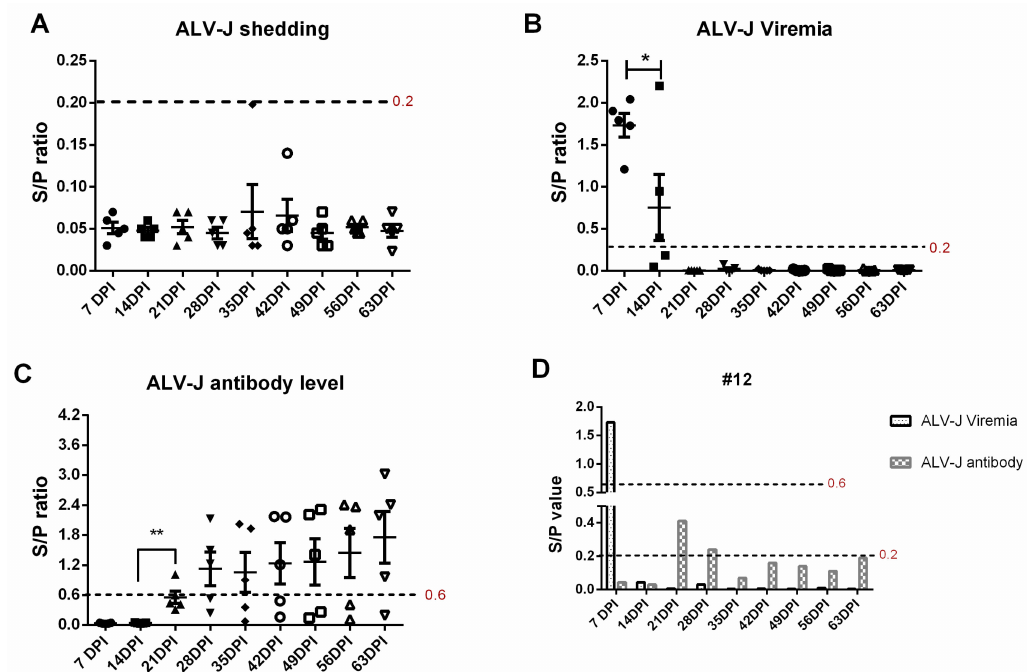
Figure 1. Dynamic detection of the avian leukosis virus subgroup J (ALV-J) shedding, ALV-J viremia, and ALV-J antibody. Five chickens were randomly selected for sampling every seven days post-infection (DPI). ( A ) ALV-J shedding was monitored via detecting the p27 expression levels in cloacal swabs. S / P value below 0.2 (red) indicated negative ALV-J shedding. ( B ) ALV-J viremia was monitored via virus isolation with the routine method. An S / P value above 0.2 (red) indicated positive ALV-J viremia. ( C ) The ALV-J antibody level in the serum was monitored using the commercial ALV-J antibody test kit. An S / P value above 0.6 (red) was considered ALV-J antibody positive. ( D ) ALV-J viremia and antibody level of chicken number 12 were analyzed from 7 DPI to 63 DPI. The paired t -test was used for statistical comparison. * p < 0.05, ** p <